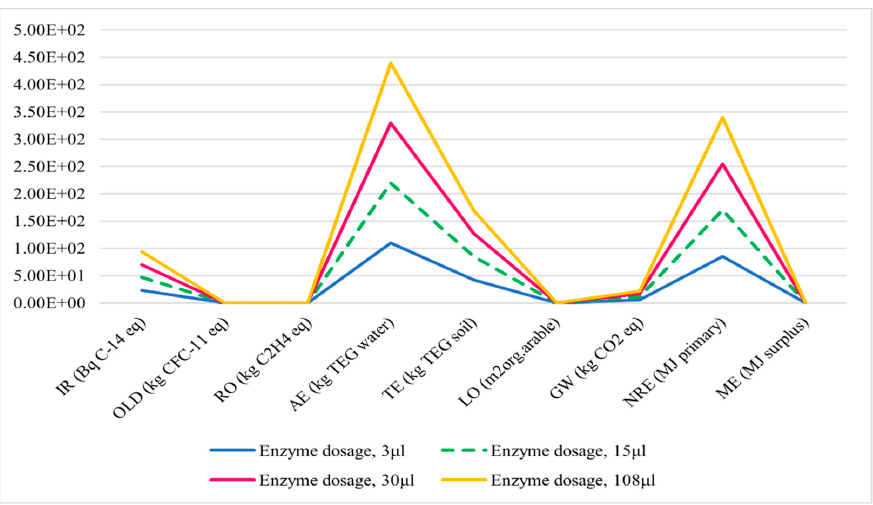
Figure 7. Environmental impact categories for different enzyme dosages in the scenarios.